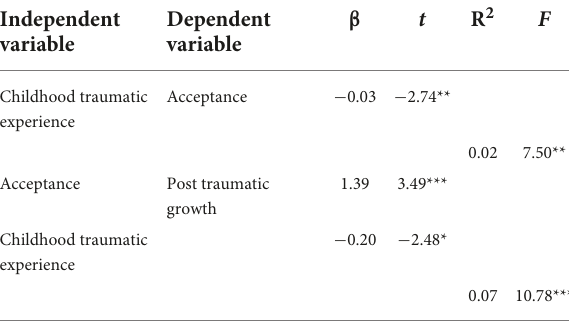
TABLE 4 The mediating role of acceptance in the relationship between childhood traumatic experience and post-traumatic